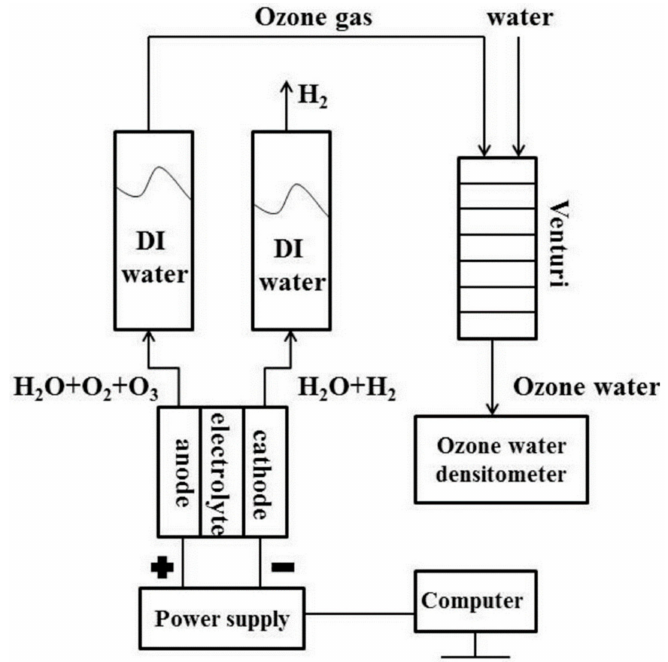
Figure 2. Proton exchange membrane water electrolysis (PEMWE) test